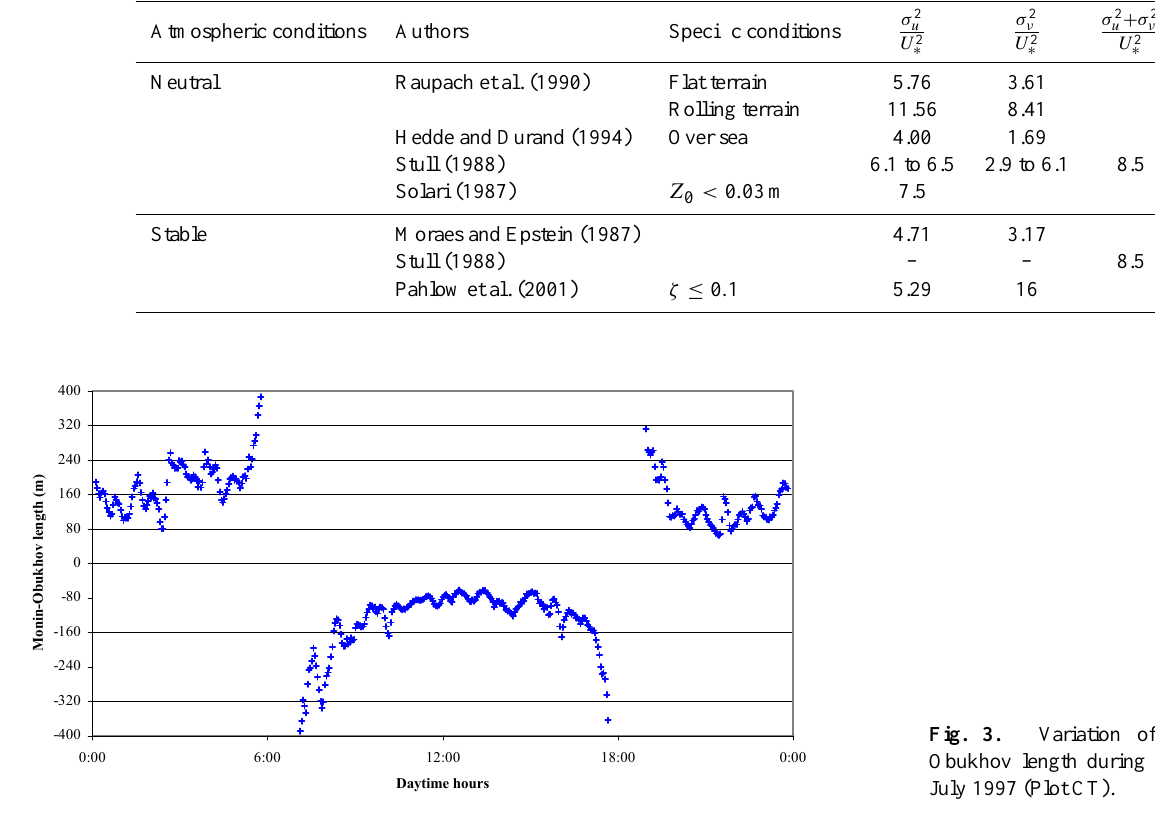
Table 1. Variances of the horizontal wind components in neutral and stable conditions in the ASL, according to authors